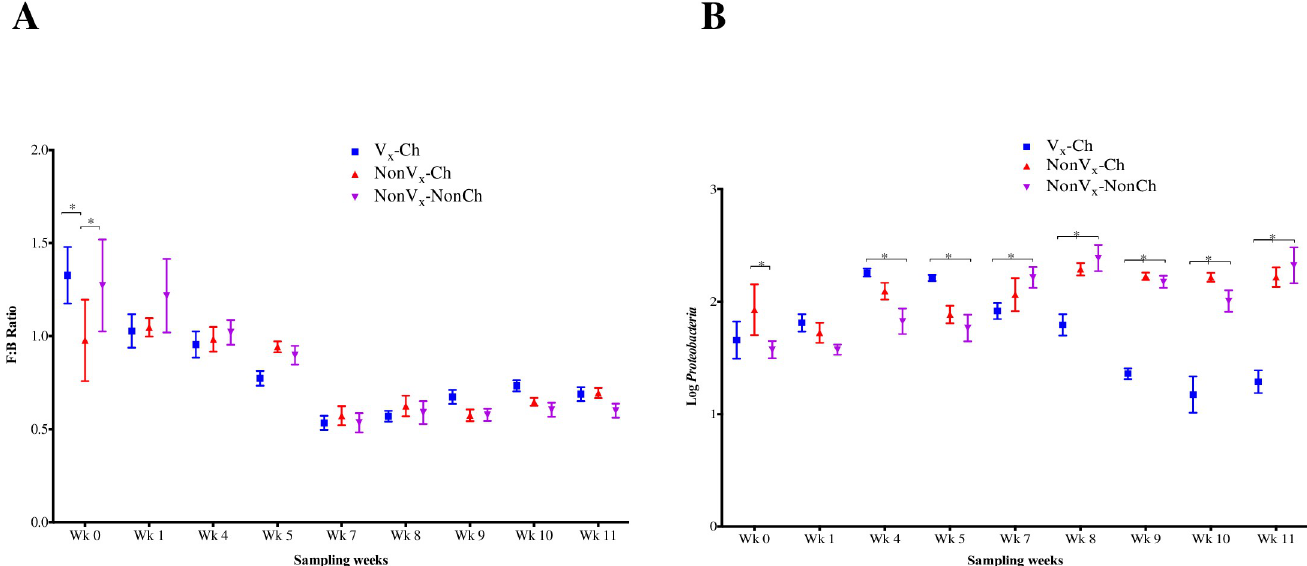
Fig 5. The Firmicutes : Bacteroidetes (F:B) ratio and the relative abundance of Proteobacteria (measured as Log 10 of number of sequences) between vaccinated and challenged (Vx - Ch), non-vaccinated and challenged (NonVx-Ch), and non-vaccinated and non-challenged (NonVx-NonCh) groups at all sampling weeks. (A) F:B ratio: Symbols (one per column) represent mean ± SEM of F:B ratio of all the samples in a group at each sampling week and (B) Log 10 Proteobacteria : Symbols (one per column) represent mean ± SEM of relative abundance of Proteobacteria (normalized after calculating Log 10 of number of sequences matching the phylum Proteobacteria ) of all the samples in a group at each sampling week.